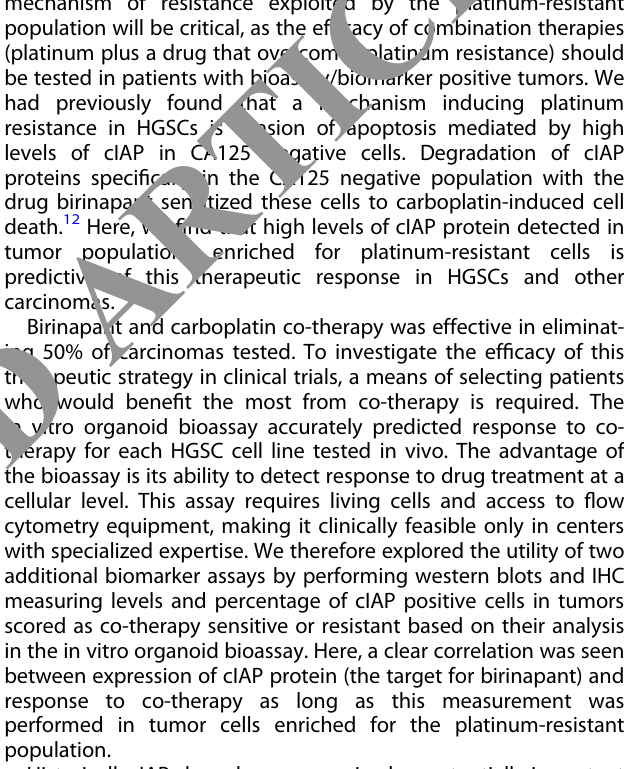
Fig. 4 Proposed strategy for overcoming platinum resistance in tumors of patients diagnosed with HGSC. a Schematic for a proposed clinical trial. We propose a proof of concept study aimed at determining the ef fi cacy of birinapant and carboplatin co-therapy in improving survival of women with HGSC. Eligible subjects would be women with newly diagnosed or recurrent HGSC with co-therapy sensitive tumors based on the in vitro organoid bioassay. Patients would be treated with six cycles of carboplatin and concurrently receive the apoptosis-enhancing drug birinapant. Progression free and OS would be assessed and compared with historic controls. The validity of two biomarker assays, western blot and IHC, aimed at measuring levels and percentage of cIAP positive cells would be correlated with response to co-therapy. b Patients with platinum-resistant HGSCs are not re-treated with carboplatin in accordance with existing standards of care. At this point second-line chemotherapy agents are administered but clinical outcomes are often poor. We suggest a different approach that involves treating